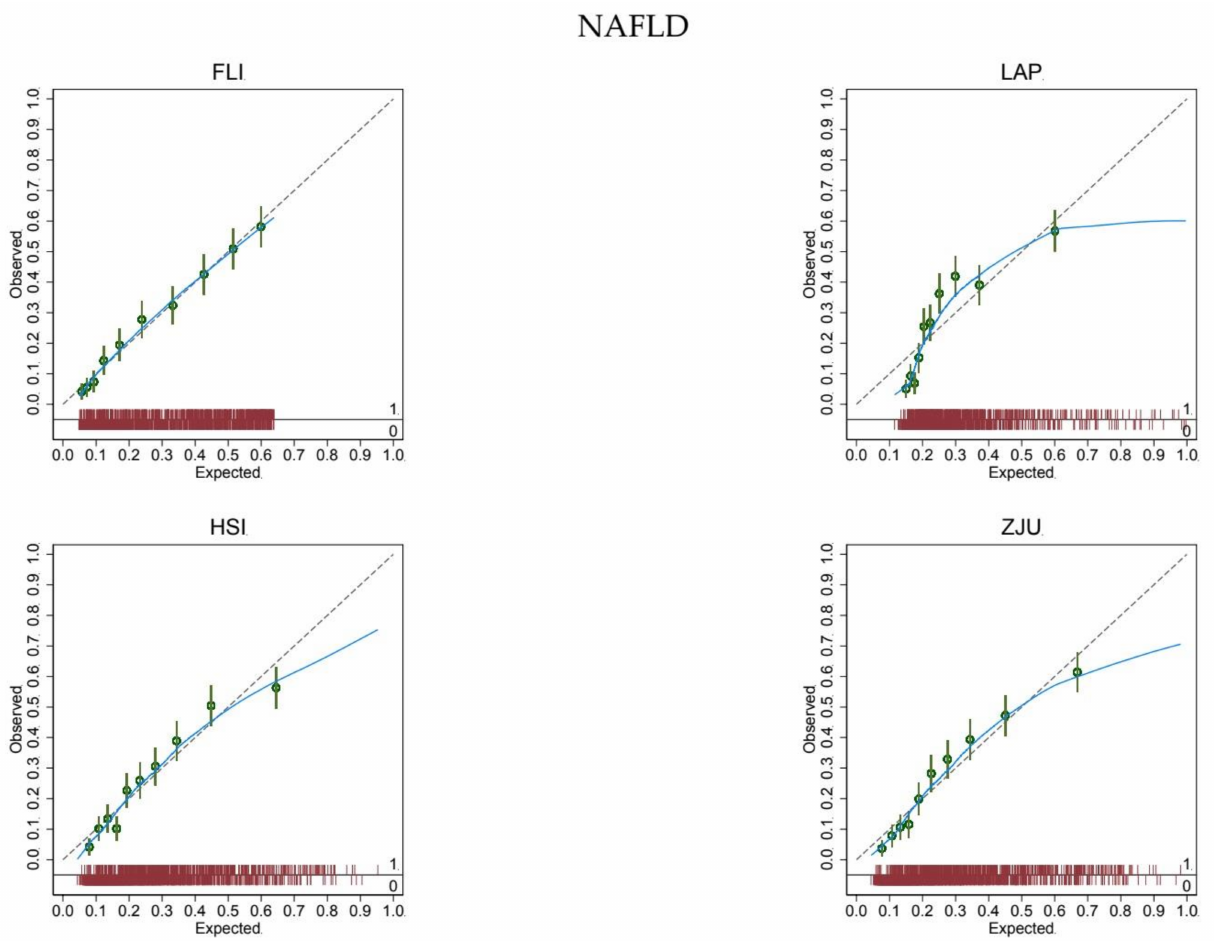
Figure 2. Calibration plots for the diagnosis of non-alcoholic fatty liver disease. The expected (predicted) risk is divided into 10 equally sized groups (tenths). The green dots and spikes on the diagonal line are average risks and 95% confidence intervals. The dotted line is the reference line of calibration. The blue line connecting the green dots is obtained by locally weighted scatterplot smoothing. The red spike plot at the bottom gives the distribution of NAFLD (0 = no; 1 = yes). Abbreviations: NAFLD =